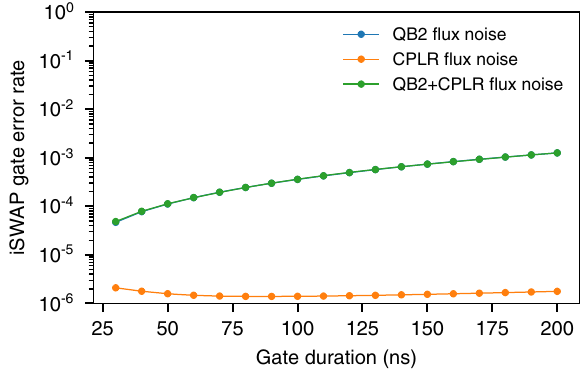
FIG. 37. Contribution of 1 =f α flux noise to error rates of iSWAP gates. Notably, the error contribution from CPLR flux noise increases as the gate duration decreases (orange circles), possibly due to stronger qubit-coupler